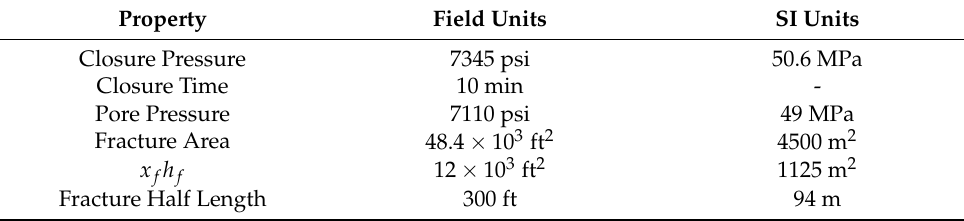
Table 3. Results of analysis of simulated